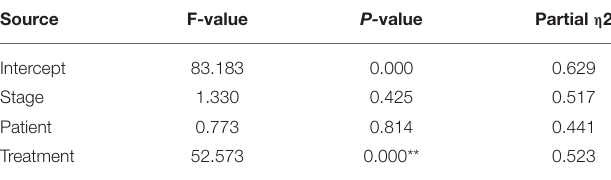
TABLE 3 | Cross-analysis of the decrease in Der p2 + Der f2.